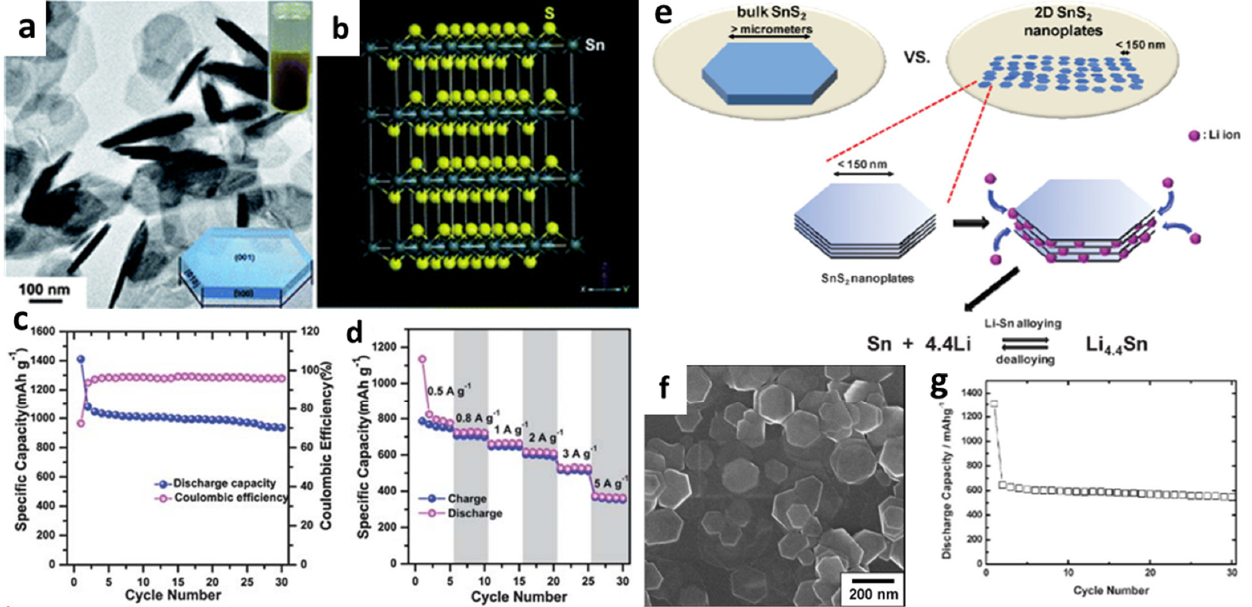
Figure 1. ( a ) A TEM image of hexagonal SnS 2 nanoplates. Inset: (top) photograph of SnS 2 nanoplate solution; (bottom) schematic diagram of a SnS 2 nanoplate. ( b ) The supercell structure of a SnS 2 crystal with A = 3a, B = 3b, C = 3c. ( c ) Cycling performance of the SnS 2 nanoplate electrode at a current density of 0.2 A/g and ( d ) charge ‐ discharge capacities at various current densities from 0.5 to 5 A/g. Reprinted with permission from Ref. [97]. Copyright 2013 RSC. ( e ) A schematic of lithiation processes for bulk versus nanoplates. ( f ) An SEM image of SnS 2 nanoplates; ( g ) life cycle performance of the SnS 2 electrode. Reprinted with permission from Ref. [94]. Copyright 2008 John Wiley and Sons, Inc.